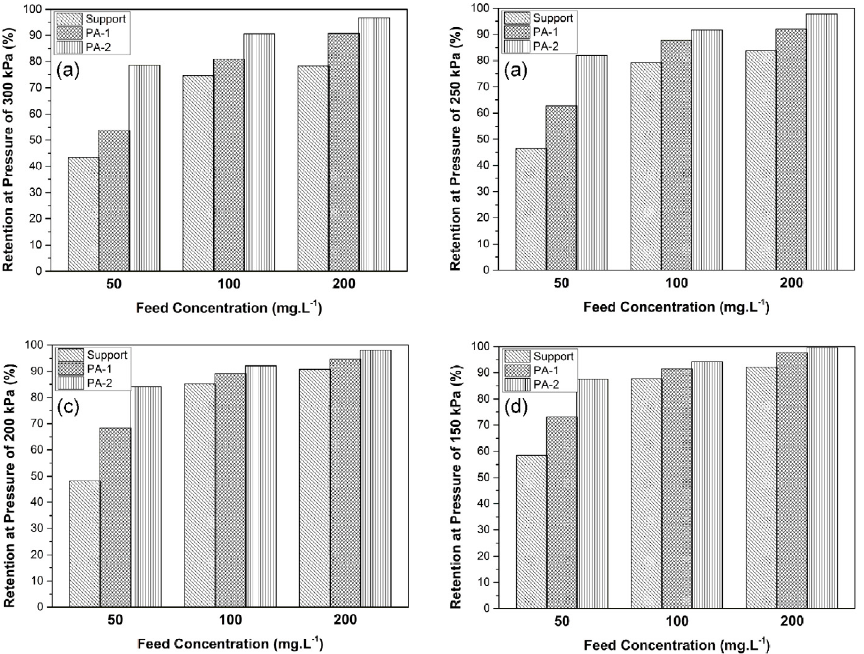
Figure 4. Results for oil rejection in the following pressures (a) 300 kPa, (b) 250 kPa, (c) 200 kPa and (d) 150 kPa.